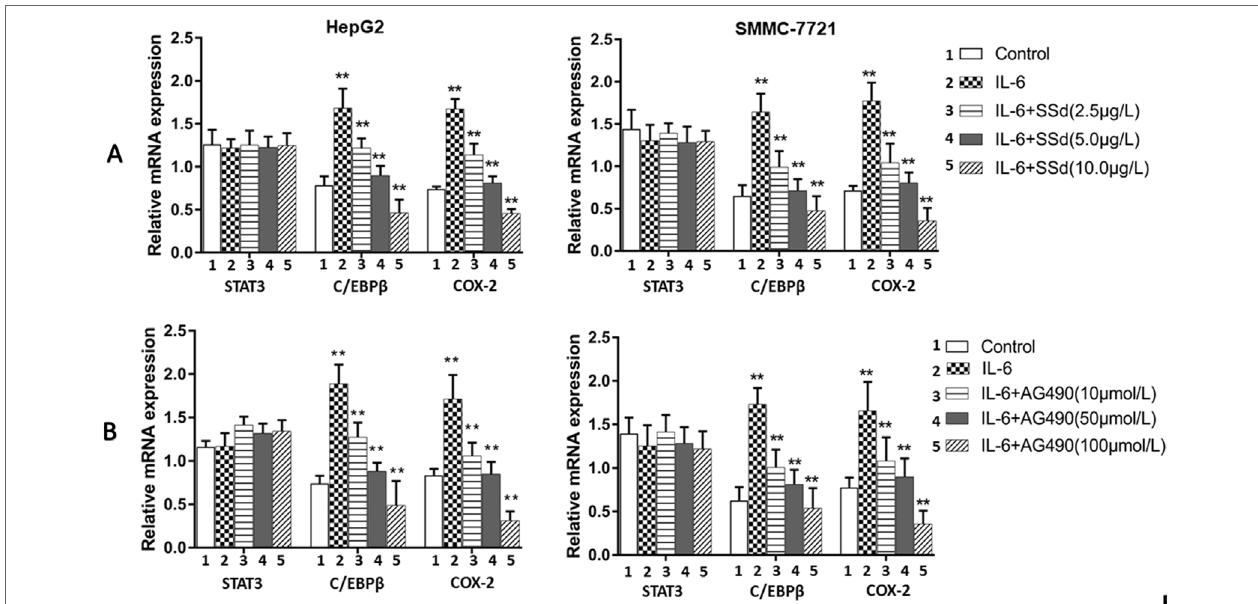
FIGURE 6 | Expression of mRNA for total STAT3, C/EBP β , and COX-2 as determined by qRT-PCR. (A) SSd treated cells. Upper panel: Tumor cells (HepG2 and SMMC-7721) were divided into five groups and treated with different concentrations of SSd as follows: 1) control group: cells received no drug treatment; 2) cells treated with IL-6 (25 ng/ml) only; 3) cells treated with IL-6 (25 ng/ml) + SSd (2.5 μg/ml); 4) cells treated with IL-6 (25 ng/ml) + SSd (5.0 μg/ml); 5) cells treated with IL-6 (25 ng/ml) + SSd (10.0 μg/ml). (B) AG490 treated cells. Lower panel: Both HepG2 and SMMC-7721 cells were divided into identical five groups and treated AG490 as various concentrations as follows: 1) control group: cells received no drug treatment; 2) cells treated with IL-6 (25 ng/ml) only; 3) cells treated with IL-6 (25 ng/ml) + AG490 (10 μmol/L); 4) cells treated with IL-6 (25 ng/ml) + AG490 (50 μmol/L); 5) cells treated with IL-6 (25 ng/ml) + AG490 (100 μmol/L). Data are expressed as relative expression using the ΔΔCq method. ** P < 0.01 and * P < 0.05 compared with group 2 (cells treated with 25 ng/ml